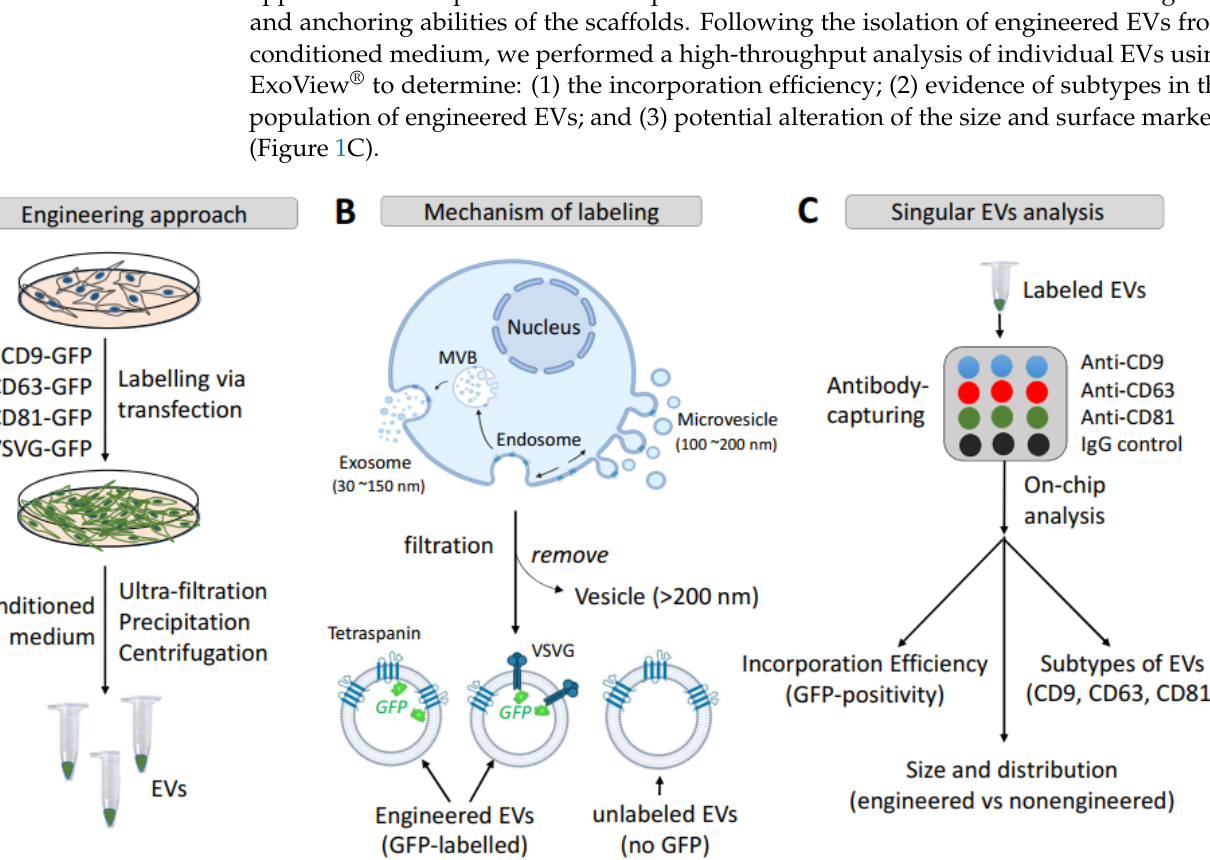
Figure 1. Strategy and molecular mechanisms underlying surface engineering of EVs via transmembrane scaffolds. ( A ) The workflow illustrates the engineering of EVs using either endogenous tetraspanins (CD9, CD63, and CD81) or exogenous vesicular stomatitis virus envelope glycoprotein (VSVG). ( B ) The molecular mechanism underlying the genetic labeling of EVs and membrane topology of the engineering scaffolds. ( C ) Methods used by on-chip analysis for characterization of scaffold-modified vs. non-modified EVs. Abbreviations: vesicular stomatitis virus envelope glycoprotein, VSVG; small extracellular vesicles, EVs; multi-vesicular bodies, MVBs.